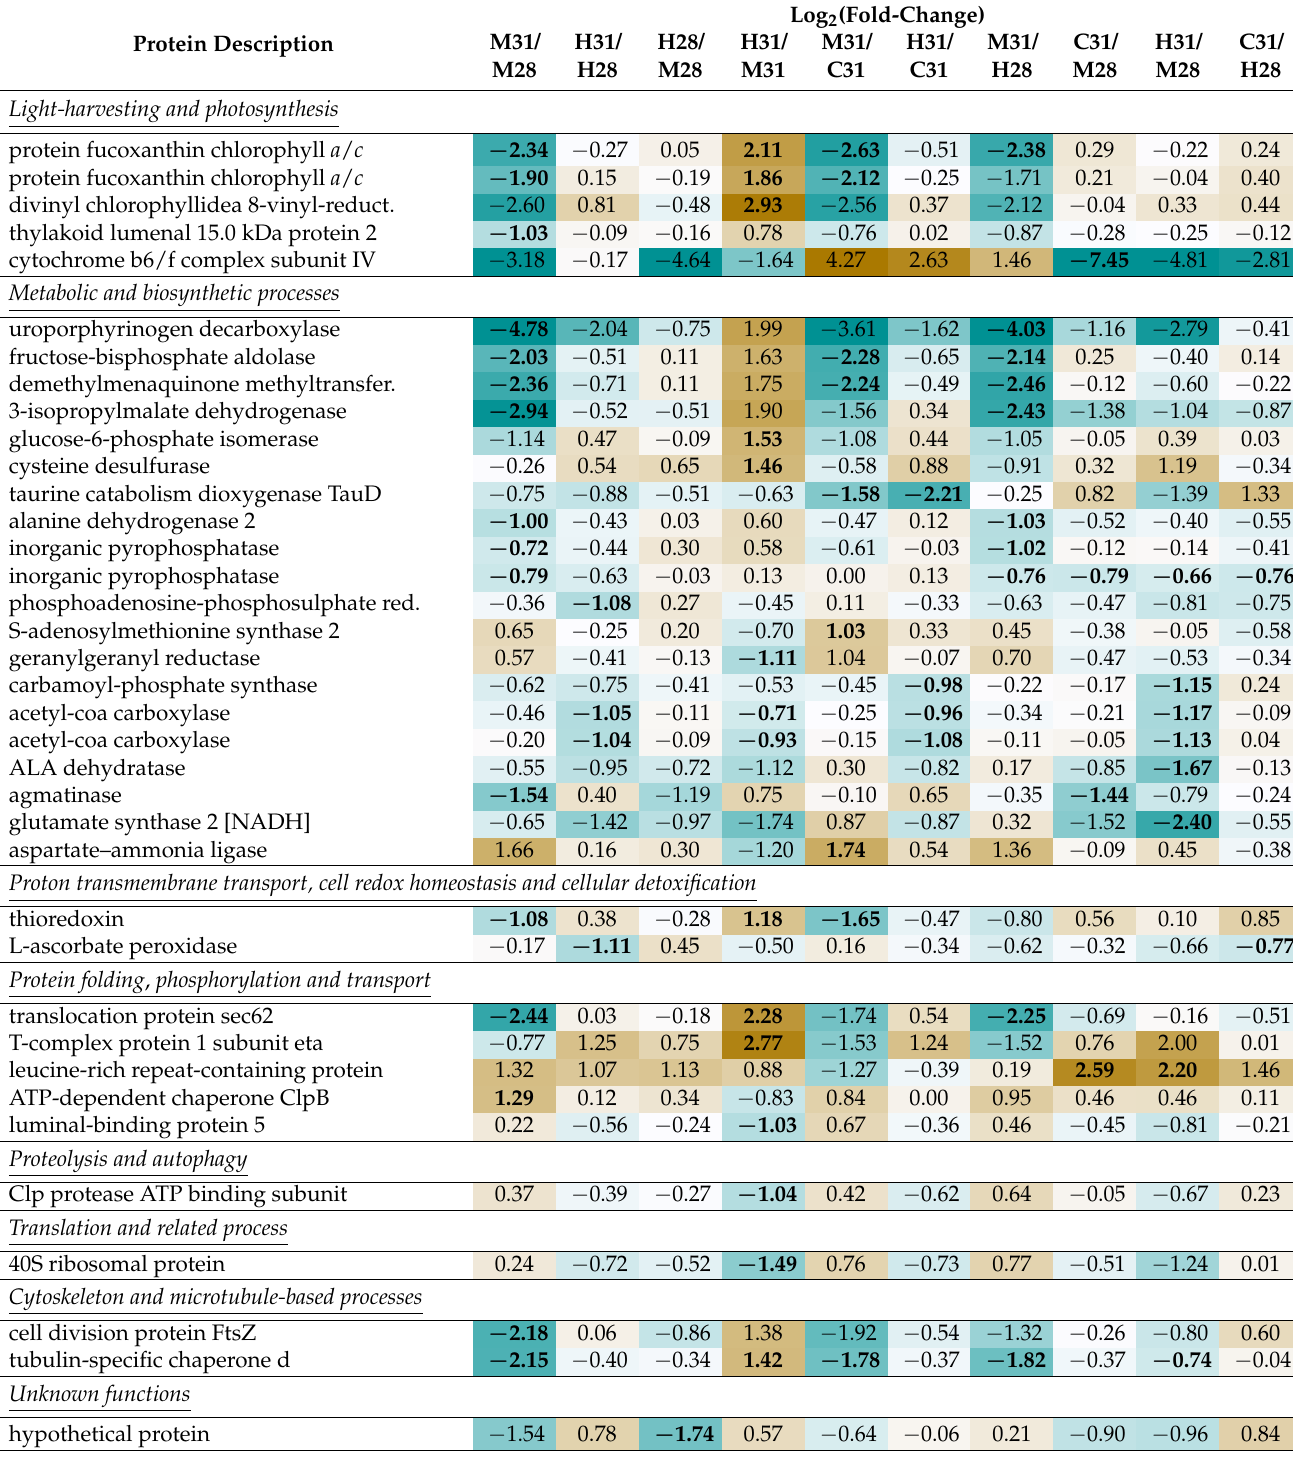
Table 3. Regulated proteins of photosymbionts of Amphistegina lobifera in response to elevated p CO 2 (‘C’ = 492 ppm, ‘M’ = 963 ppm, ‘H’ = 3182 ppm) at 28 ◦ C or 31 ◦ C, without the C28 treatment (GLM, q ≤ 0.05, Tukeys’ p ≤ 0.05, and log 2 FC ≥ |1|). Proteins are arranged by their major functions and processes according to GO terms, however, these roles